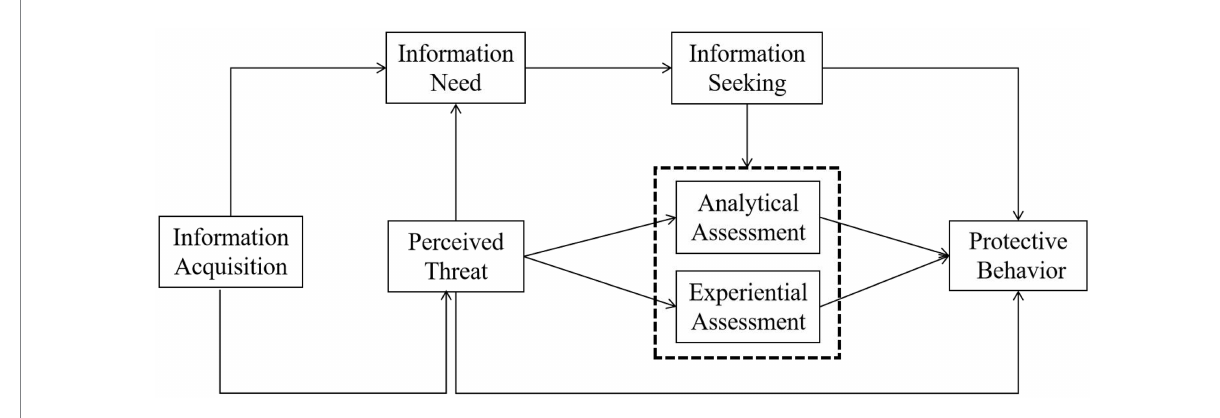
FIGURE 1 Conceptual